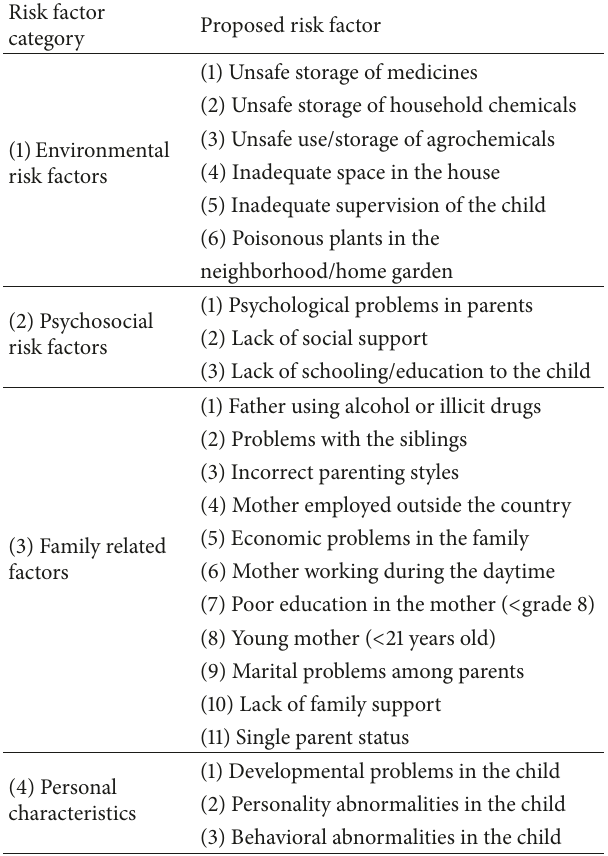
Table 1: Exposures of interest: the twenty-three proposed risk factors for acute poisoning among children aged 1–5